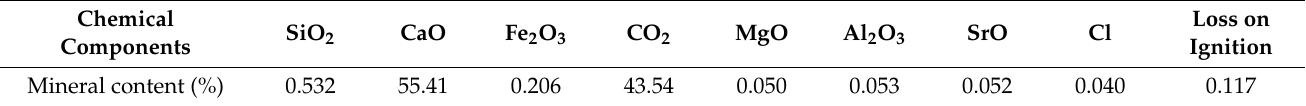
Table 2. Main chemical composition content of the rock sample and LS (wt%) [7].